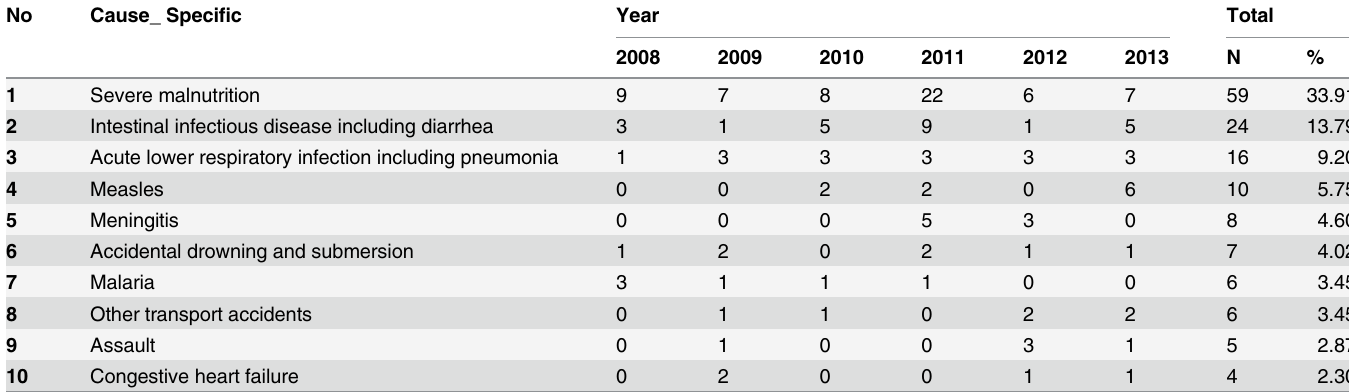
Table 5. Top 10 causes of death among children 5 – 14 year of age in Kersa HDSS, 2008 –